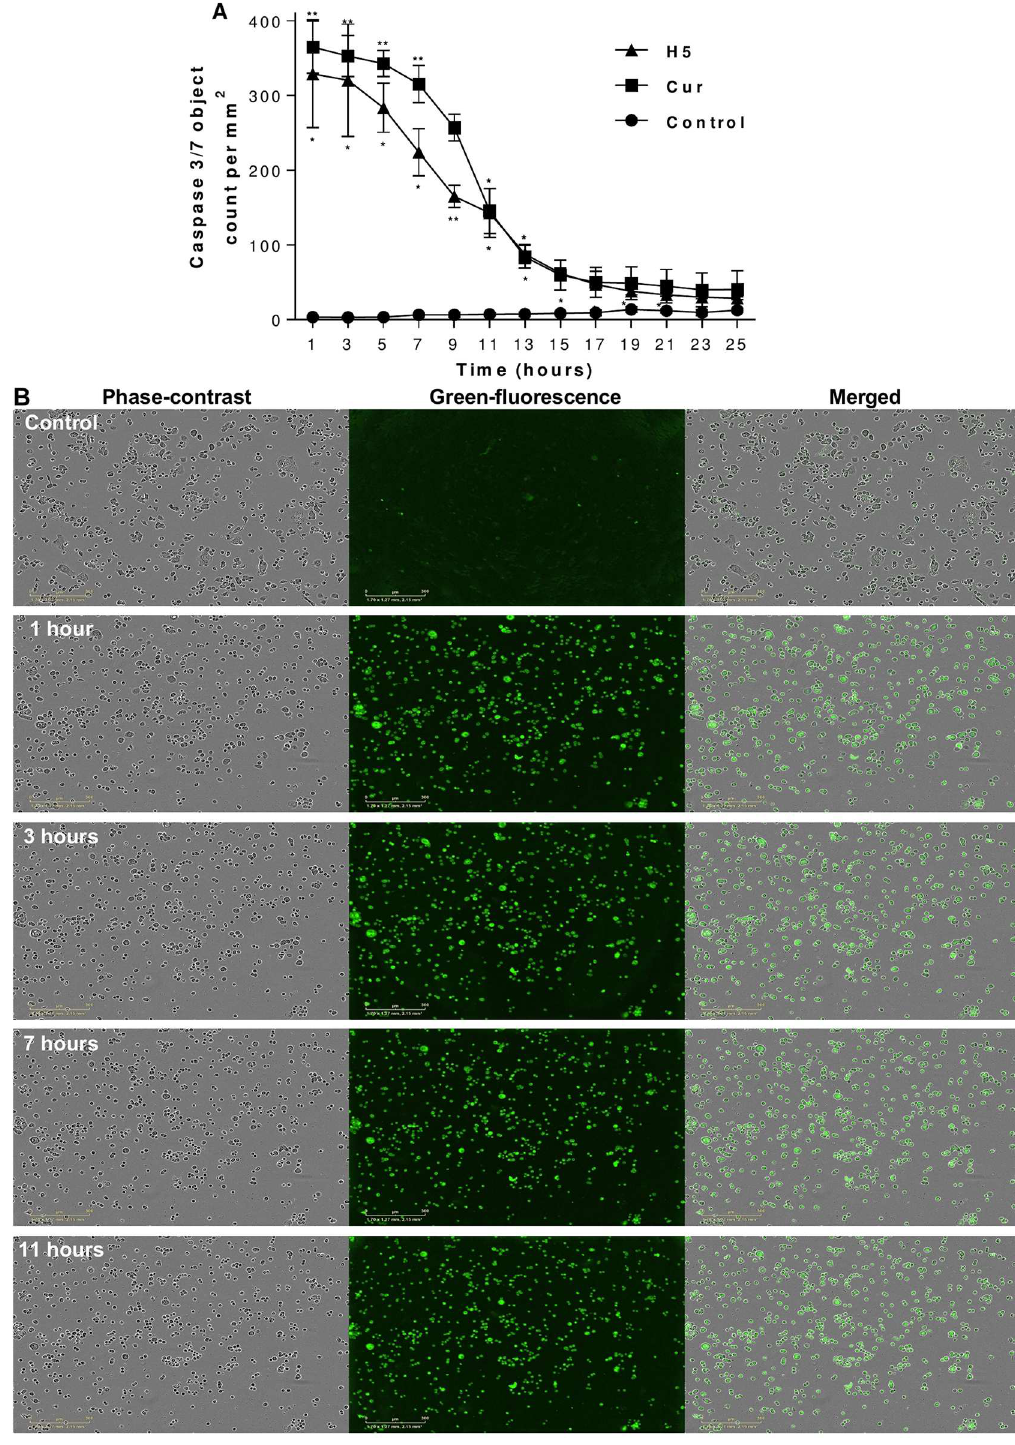
Fig 7. Effect of curcumin treatment on caspase-3/7activity and morphological changes in AsPC-1 cells. AsPC- 1 cells were treated with free curcumin and the H5 formulation containingcurcumin, with the effective curcumin concentration equivalent to the IC50 in both cases. Caspase-3/7 activity (A) , with morphologicalchangesin real-time using phase-contrast and green fluorescence images showingapoptosis (B) . The data are shown as the mean ± SD of three independentreplicates. Statistical analysisby unpairedstudent t -test: * p < 0.05; ** p < 0.001. Scale bar represents 300 μ